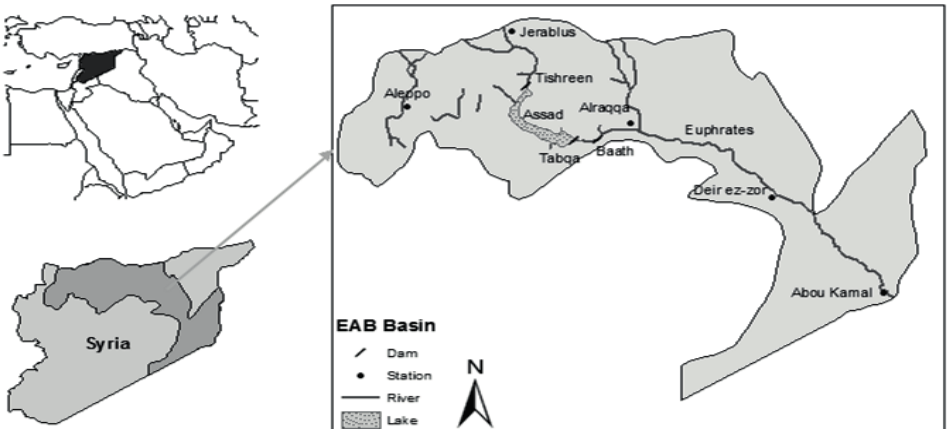
Fig. 1 Map of Syria with study area.